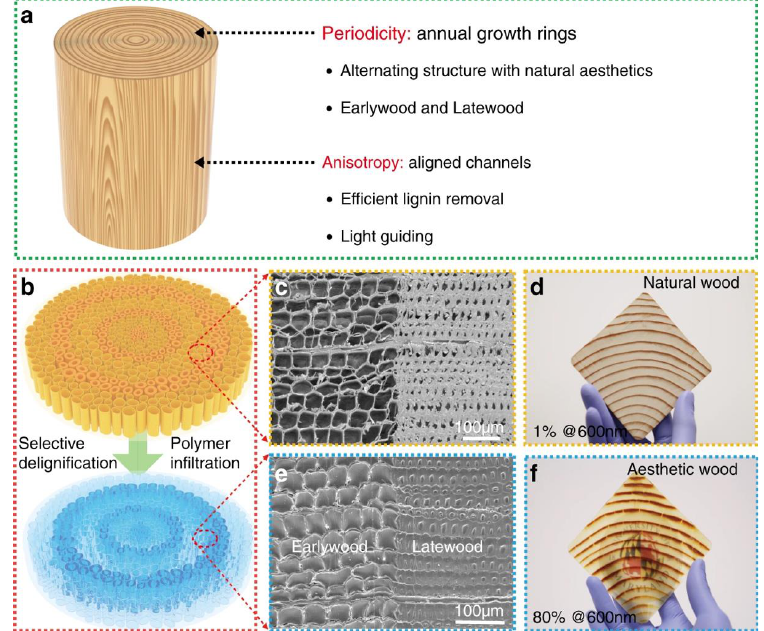
Figure 29. ( a ) An indication of the design that combines the periodicity (annual growth rings) with the anisotropy (aligned channels) of wood to produce a new type of transparent wood composite. ( b ) Schematic displaying the procedures for fabricating aesthetic wood (aesthetic wood-R) from natural Douglas fir wood with vertically aligned cells and annual growth rings after fast, spatially selective delignification and polymer infiltration. ( c , e ) Typical cross-sectional SEM images of natural wood and dense aesthetic wood-R microstructures after polymer infiltration (there is a sharp boundary between earlywood—EW and latewood—LW). ( d , f ) Photos showing a large piece of aesthetic wood-R (86 × 86 × 2mm 3 ) with preserved wood patterns and high average transparency (80% transmittance at 600nm) derived from Douglas fir. Reprinted from [44] under CC-BY